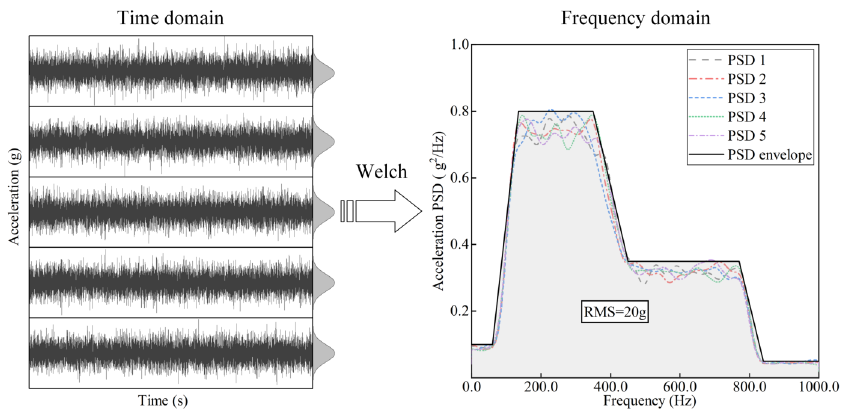
Figure 11. Random vibration acceleration excitation.